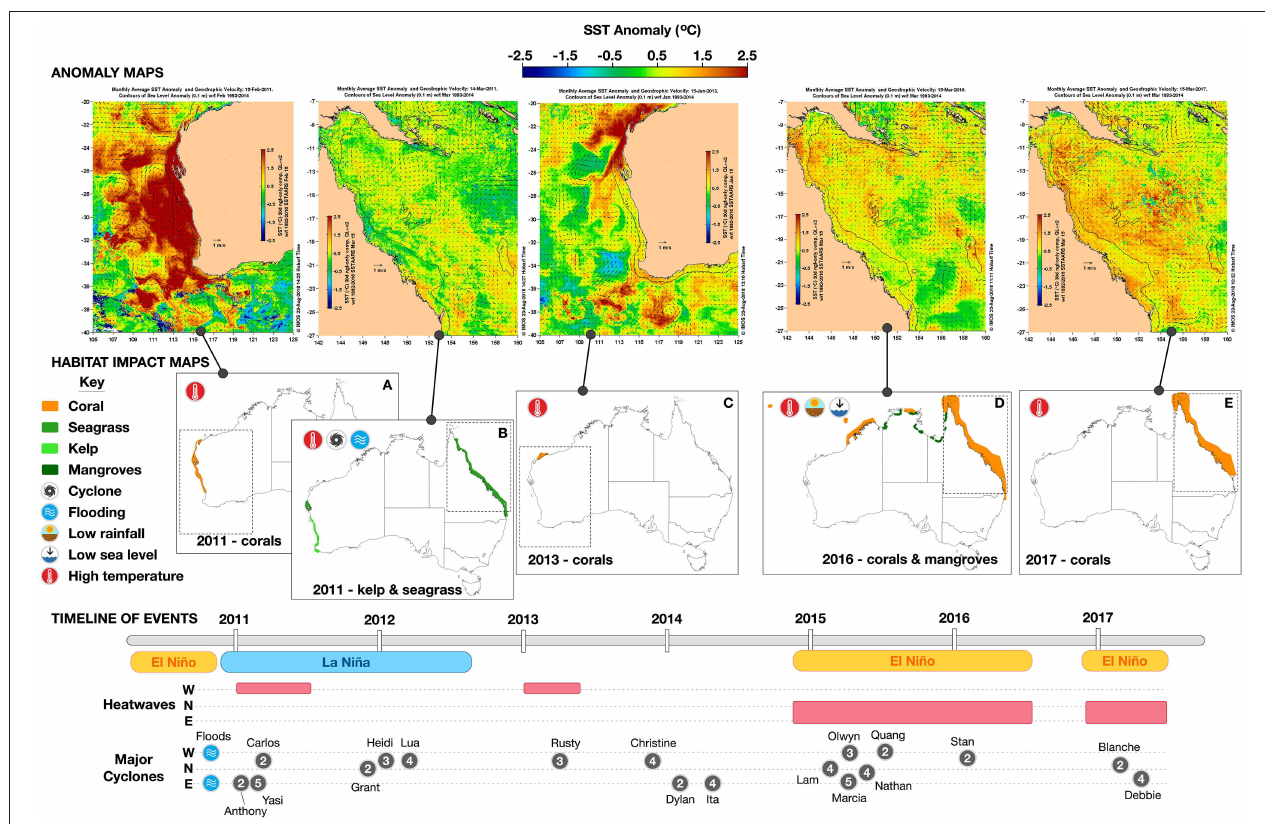
FIGURE 2 | A schematic of the timeline of extreme events and habitat impacts. Sea surface temperature anomaly maps ( ◦ C increase above the monthly climatology over the period 1993–2014) associated with each extreme event are shown, as well as the indicative spatial footprint of the habitat impacts. The maps (A–E) indicate the habitat types affected and the kind of extreme event causing the impact (e.g., MHW, tropical cyclone, flood, etc.), and were created based on maps or geographic details provided in the literature cited in the main text. Thermal anomalies at the time of each ECE are depicted in the figures immediately above. A timeline of the specific types of extreme events are shown in the bottom part of the diagram—with only cyclones (gray circles) of category 2 or above shown (source www.bom.gov. au). W, N, and E indicate the region of Australia (West, North, East)